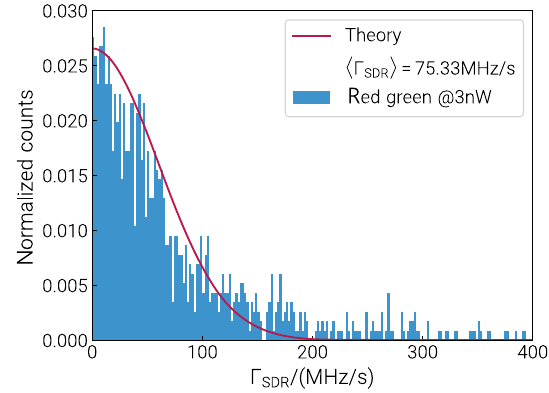
FIG. 9. Spectral diffusion rate distribution. Probability distribu- tion of Γ for red and green excitation light at 5 nW. The SDR distribution agrees well with the theoretical prediction (red) derived ; τ Þ ¼ 3 . 41 × 10 24 = Joule = s 2 for a from the Wiener process at η ð ω I spectral diffusion rate of 75 . 35 MHz = s at 5 nW and τ ¼ 2 . 3 s , which was used for modeling the diffusion